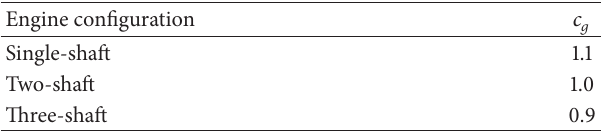
Table 3: Configuration